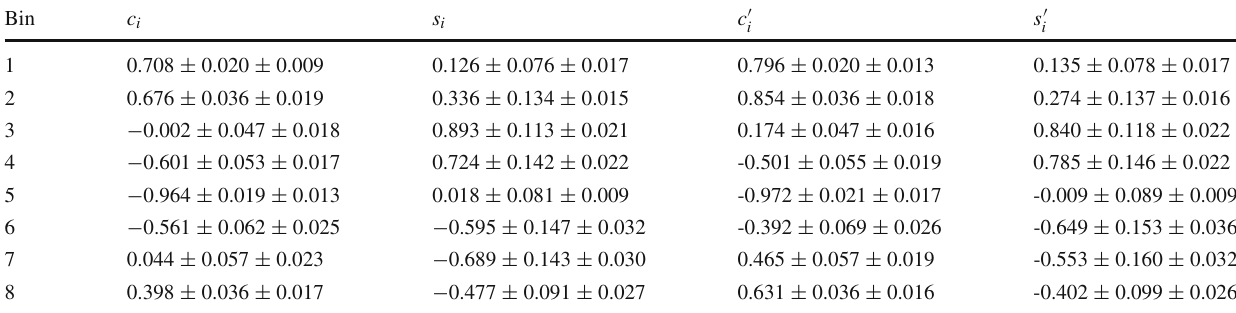
Table 7 Values of c ( (cid:7) ) the second is systematic